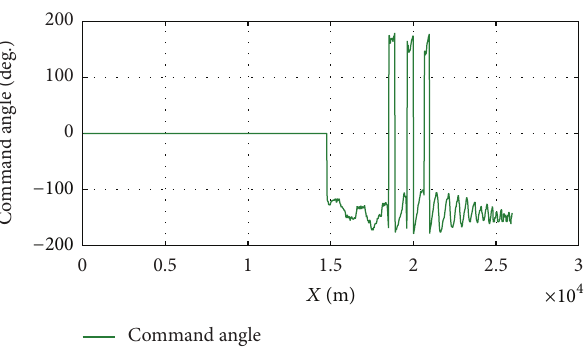
Figure 18: Sideslip angle.